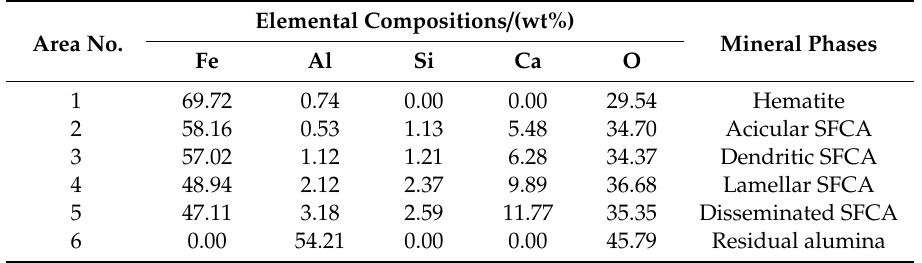
Figure 14. E ff ect of hercynite on the characteristics of the bonding matrix (P: Pore; a → b: Rotate 90 ◦ to the right; ( a , b ) are the optical and SEM photographs of the reaction interface respectively; ( c ) is the photograph of line scan in ( b )). Table 9. EDS analysis results for areas in Figure